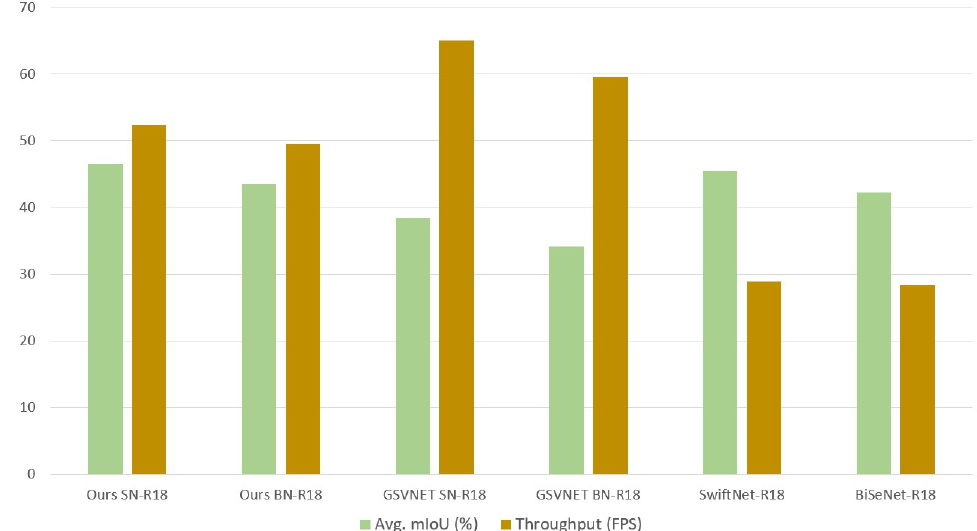
Figure 3. Comparison of accuracy-throughput performance using our dataset on our end hardware, NVIDIA Jetson TX1. Our models, exclusive of the pre-trained GSVNET SN-R18 or BN-R18 and SwiftNet-R18 or BiSeNet-R18, are trained and validated with our dataset.